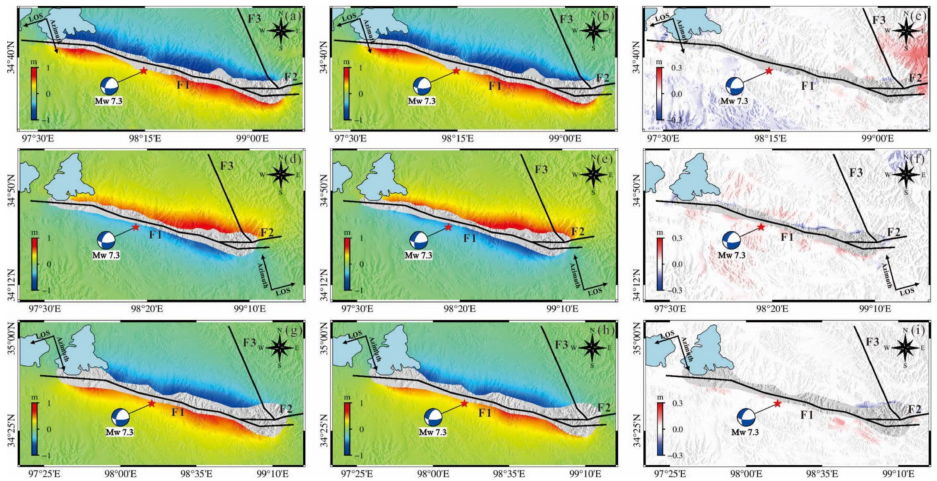
Figure 3. InSAR deformation caused by the 2021 Mw 7.3 Maduo earthquake. InSAR deformation observed by ALOS-2 descending orbital track ( a ), Sentinel-1 ascending orbital track ( d ), and Sentinel-1 descending orbital track ( g ). ( b , e , h ) The InSAR deformation predicted by the estimated faulting model. ( c , f , i ) The residual between the observed and predicted InSAR deformation. Black lines denote the detected fault surface trace, and the red star indicates the epicenter of the 2021 Maduo earthquake. F1 and F2: The two main seismogenic faults, F3: Changmahe